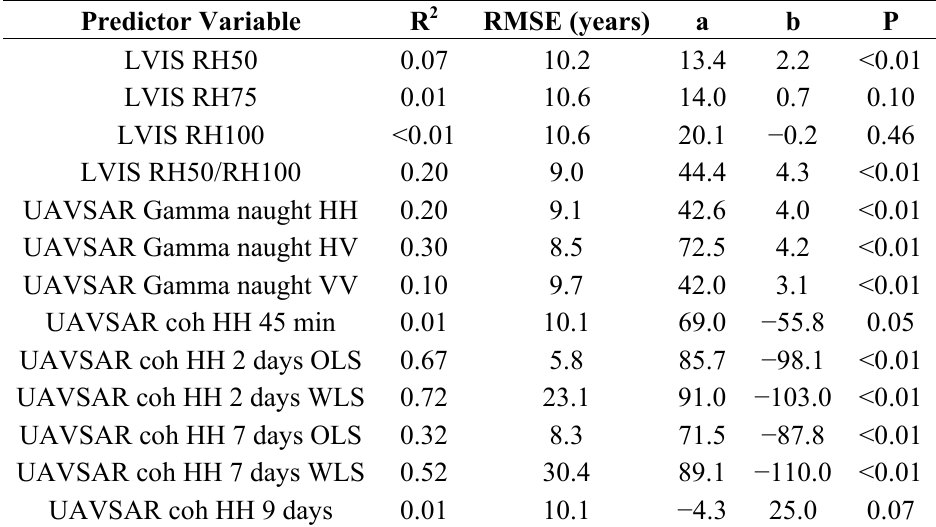
Table 3. Modeling forest patch age from active remote sensing data. Regression equations are of the form Age (years) = a + b × X where X is the predictor variable. Statistically significant models are shown in bold. OLS = ordinary least squares; WLS = weighed least squares. Minimum overlap with UAVSAR/LVIS swath is 1